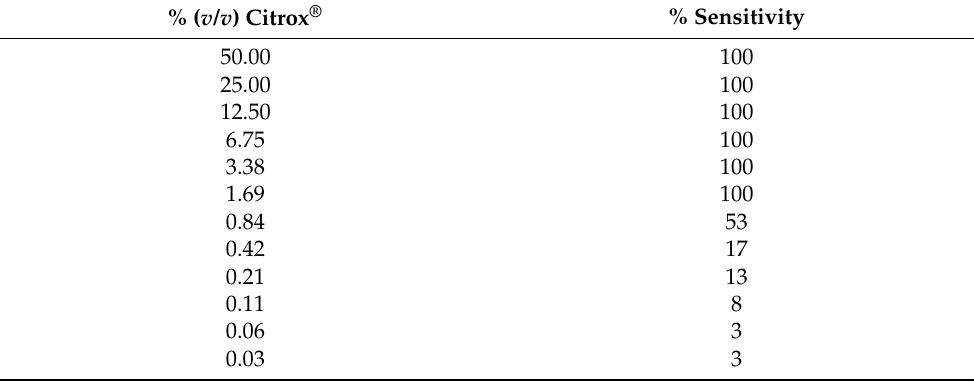
Table 6. Inhibitory effect of Citrox ® solutions at different